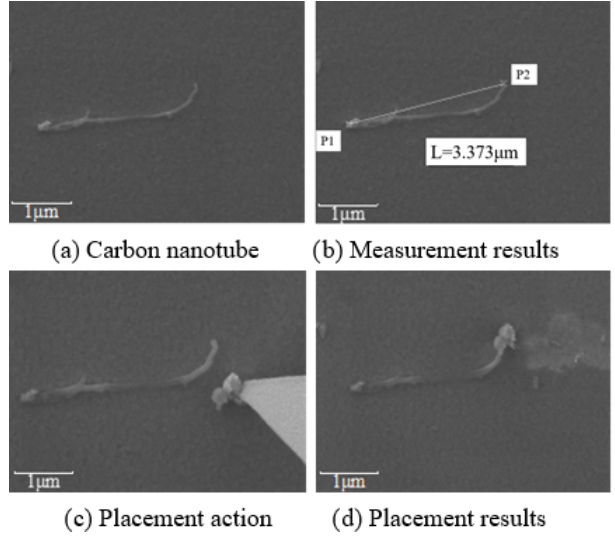
Figure 11. 3D construction of carbon nanotube–nanocluster cluster structure on ITO